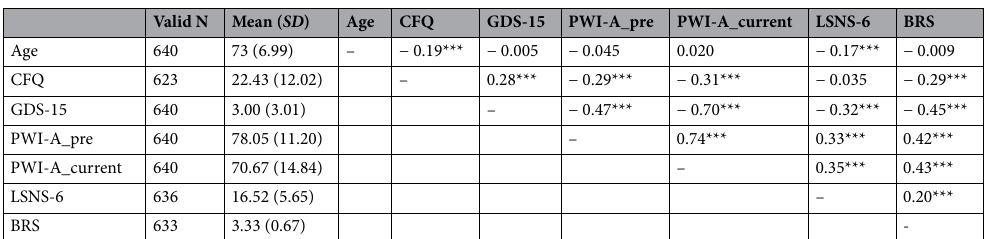
Table 1. Means (standard deviations) and Pearson correlations between age and the total scores of the questionnaires in the survey. CFQ Cognitive Failures Questionnaire total score, GDS-15 Geriatric Depression Scale-15 total score, PWI-A_pre Personal Wellbeing Index-Adults total score retrospectively assessed for the period before COVID-19, PWI-A_current Personal Wellbeing Index-Adults total score assessed for the current month (i.e., during the COVID-19 period); LSNS-6 Lubben Social Network Scale-6 total score, BRS Brief Resilience Scale mean score; *** p <